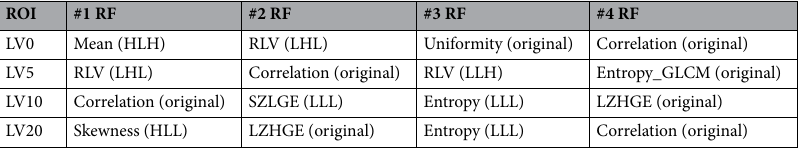
Table 3. Top 4 radiomic features selected most frequently for 10 subsets for each ROI. RLV, run-length variance; GLCM, gray level co-occurrence matrix; SZLGE, small zone low gray-level emphasis; LZHGE, large zone high gray-level